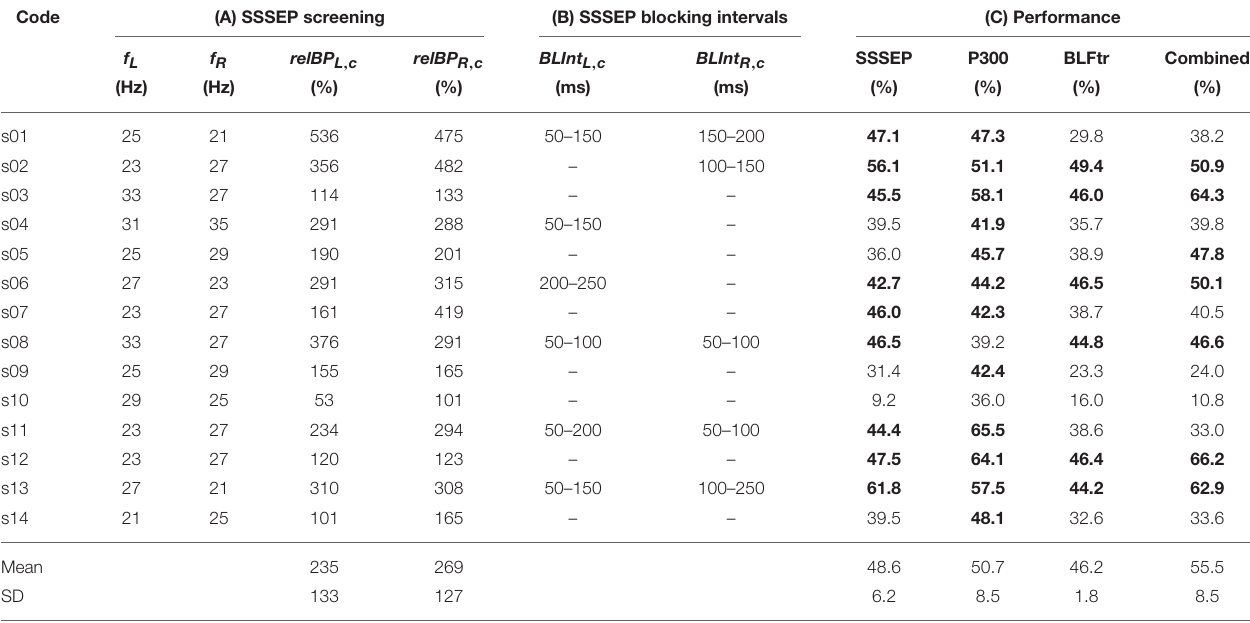
TABLE 1 | Summary of individual screening, blocking interval estimation, and classification results.